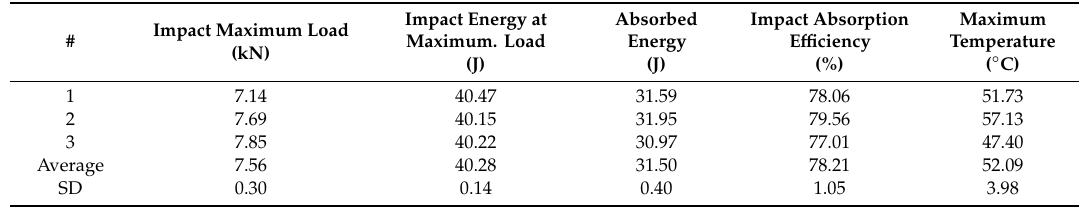
Table 5. Impact test results of Type